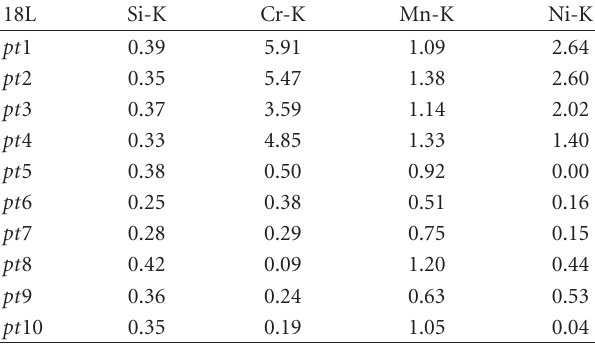
Table 2: Specification of the chemical composition investigation results for the surface layer after the alloy steel 1H18N9 electrode alloying; pulse current I = 32 (A), pulse Ti = 25( μ s), electrode material: 1H18N9.